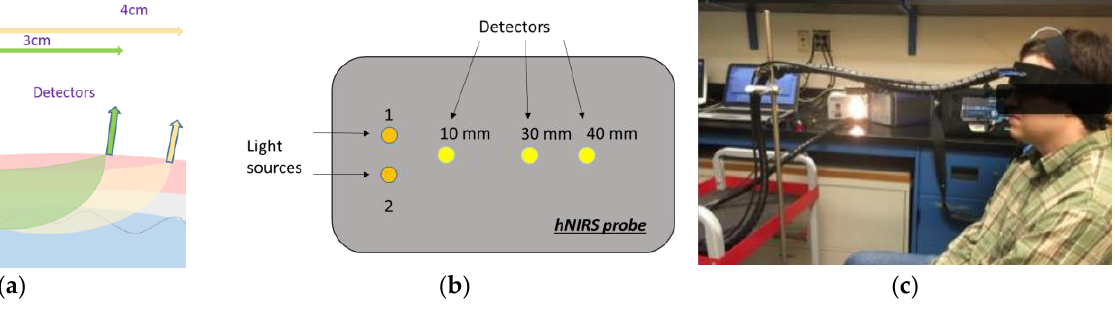
Figure 1. hNIRS measurement setup: ( a ) approximate interrogated volumes in the scalp, skull, and brain; ( b ) optical sensor layout; and ( c ) subject position.